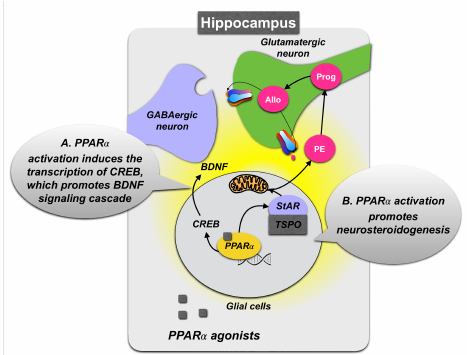
Figure 3. Schematic representation of PPAR α signaling pathway in the hippocampus following agonist administration. ( A ) PPAR α activation, upon dimerization with the retinoid receptor (RXR), induces transcriptional regulation of cyclic AMP response element-binding protein (CREB), which promotes the stimulation of brain-derived neurotrophic factor (BDNF) signaling pathway, resulting in antidepressant-like effects and improving learning and memory. ( B ) PPAR α activation can also induce allopregnanolone (Allo) biosynthesis by upregulating neurosteroidogenic enzymes and proteins, including the steroidogenic acute regulatory protein (StAR). The interaction of StAR with cholesterol and translocator protein (TSPO) leads to cholesterol entry into the mitochondria and its conversion into pregnenolone (PE). In hippocampal glutamatergic pyramidal neurons, PE is transformed into progesterone (Prog) and then Allo, which, by interacting with GABA A receptors, modulates emotional